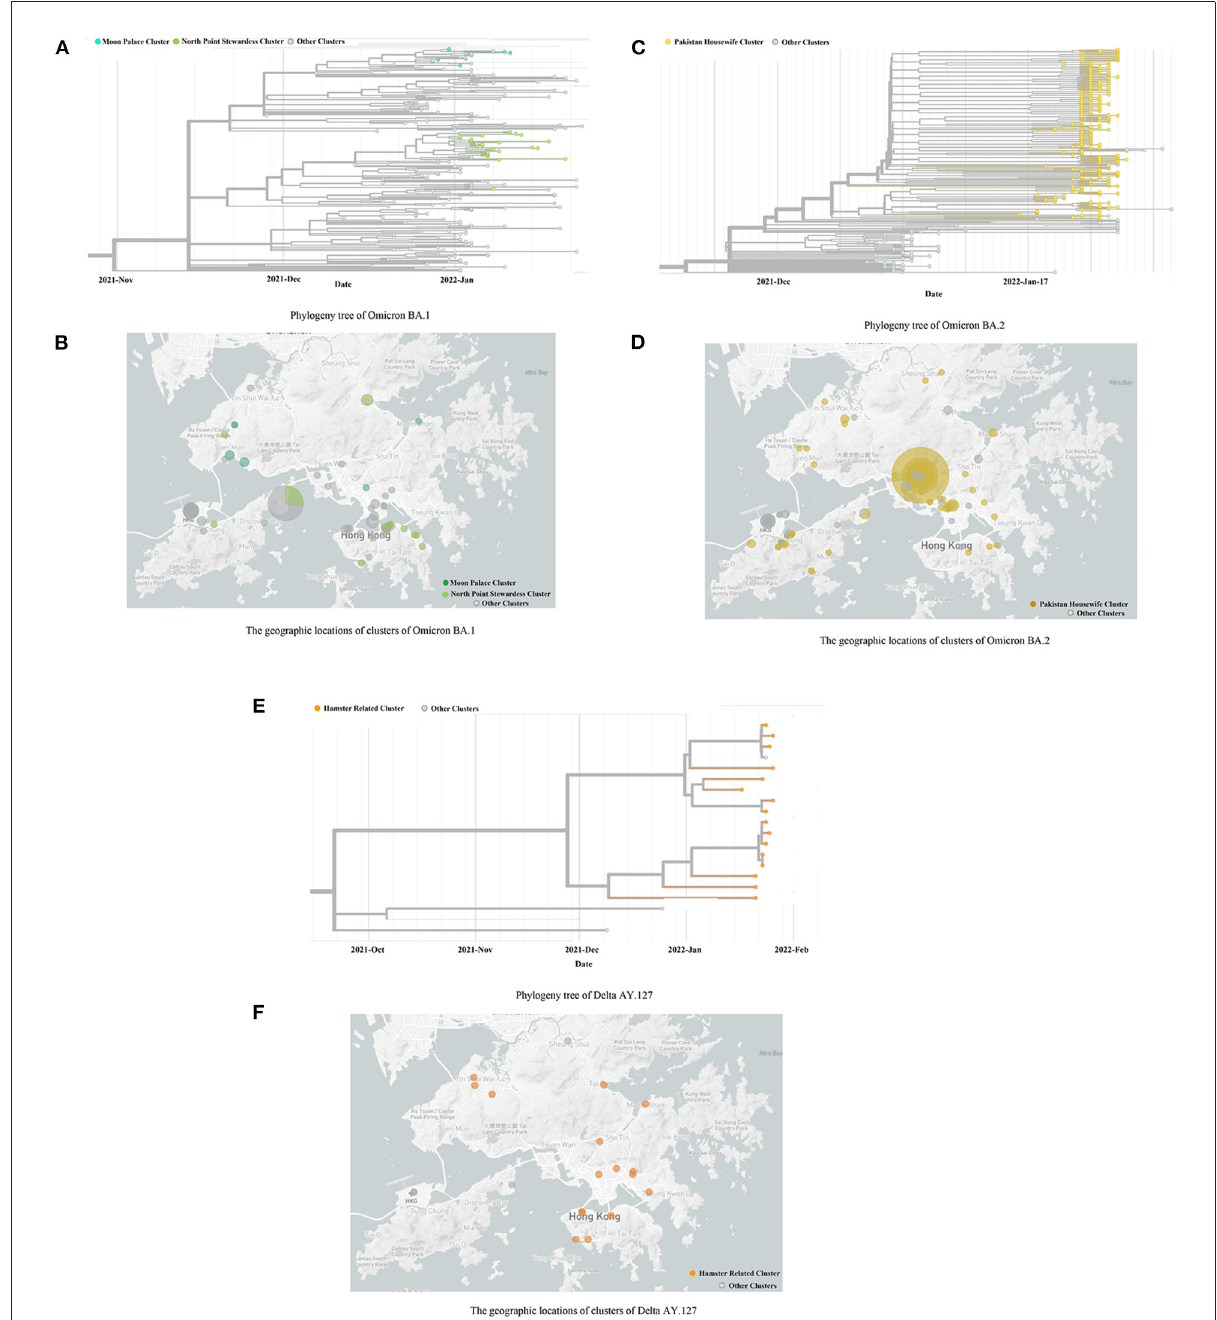
FIGURE2 The Phylogeny trees and geographic locations of cases with Omicron BA.1, BA.2, and Delta AY.127. (A,B) indicates the Phylogeny trees and geographic locations of cases with Omicron BA.1. (C,D) indicates the Phylogeny trees and geographic locations of cases with Omicron BA.2. (E,F) indicates the Phylogeny trees and geographic locations of cases with Delta AY.127. (A) Phylogeny tree of Omicron BA.1. (B) The geographic locations of clusters of Omicron BA.1. (C) Phylogeny tree of Omicron BA.2. (D) The geographic locations of clusters of Omicron BA.2. (E) Phylogeny tree of Delta AY.127. (F) The geographic locations of clusters of Delta AY.127.